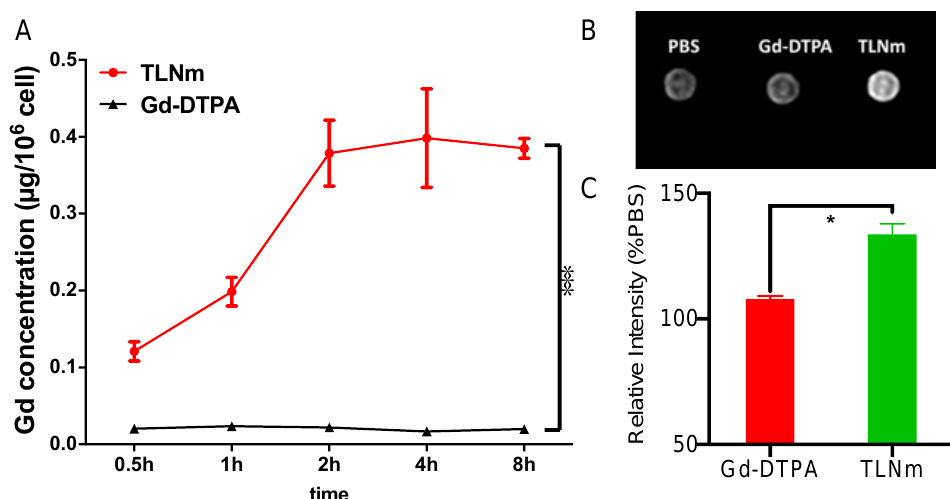
Figure 4. ( A ) Cell uptake of TLNm (red) and Gd-DTPA (black) was determined in HepG2 cells and showed a highly significant difference (***, p < 0.001; n = 3); ( B ) T I -weighted axial scan for HepG2 cells; ( C ) the signal intensity ratio of HepG2 cells treated with PBS, Gd-DTPA, and TLNm. Cells incubated with samples at a Gd concentration of 20µg/mL for 2 h. Signal intensity showed a statistically significant difference (*, p < 0.05; n = 3). Notes: Here, PBS served as a blank control without Gd. Abbreviations: TLNm, TLNm; Gd-DTPA, gadopentetate dimeglumine, Magnevist.